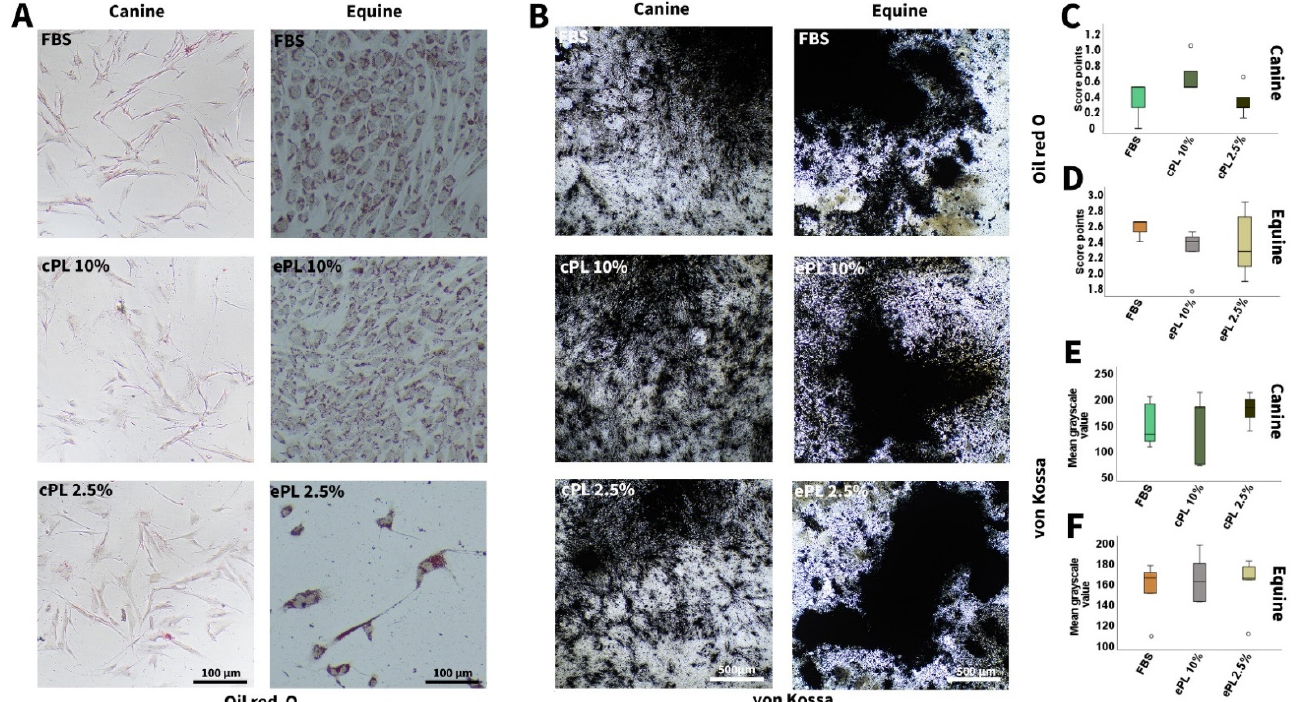
Figure 5. Adipogenic and osteogenic differentiation. Representative bright-field photomicrographs show canine (left column) and equine (right column) mesenchymal stromal cells (MSC) after adipogenic ( A ) and osteogenic ( B ) differentiation, with Oil Red O and von Kossa staining, respectively. Boxplots display the corresponding data obtained by scoring adipogenic differentiation of canine ( C ) and equine ( D ) MSC and image analysis using Fiji ImageJ after osteogenic differentiation of canine ( E ) and equine ( F ) MSC. MSC were cultured in the media indicated before differentiation was induced (FBS: fetal bovine serum; cPL: canine platelet lysate; ePL: equine platelet lysate). Data were obtained using MSC from the same n = 5 donor dogs or horses in each group.